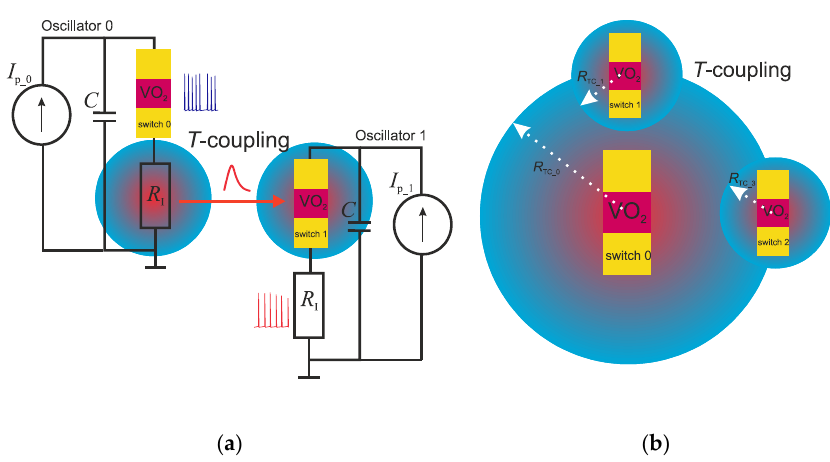
Figure 13. Variants of the technical implementation of one-way thermal coupling: ( a ) through an additional current resistor, ( b ) by making switches with different radii of thermal exposure R TC .